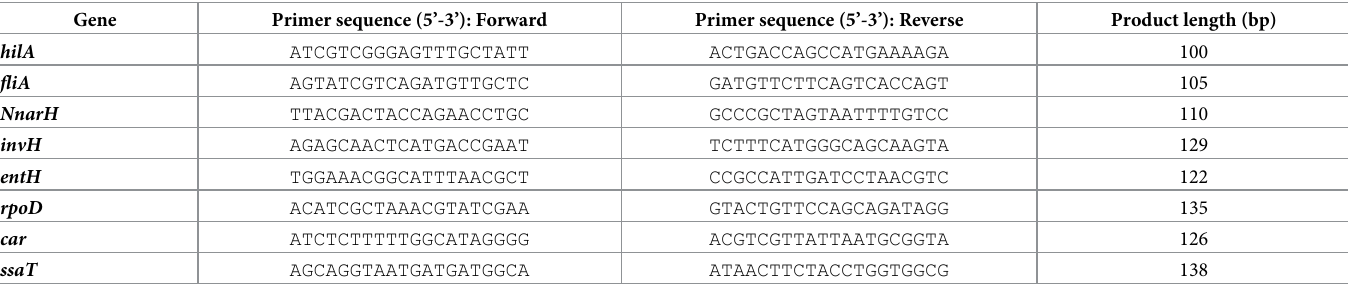
Table 1. List of primers used in this study.